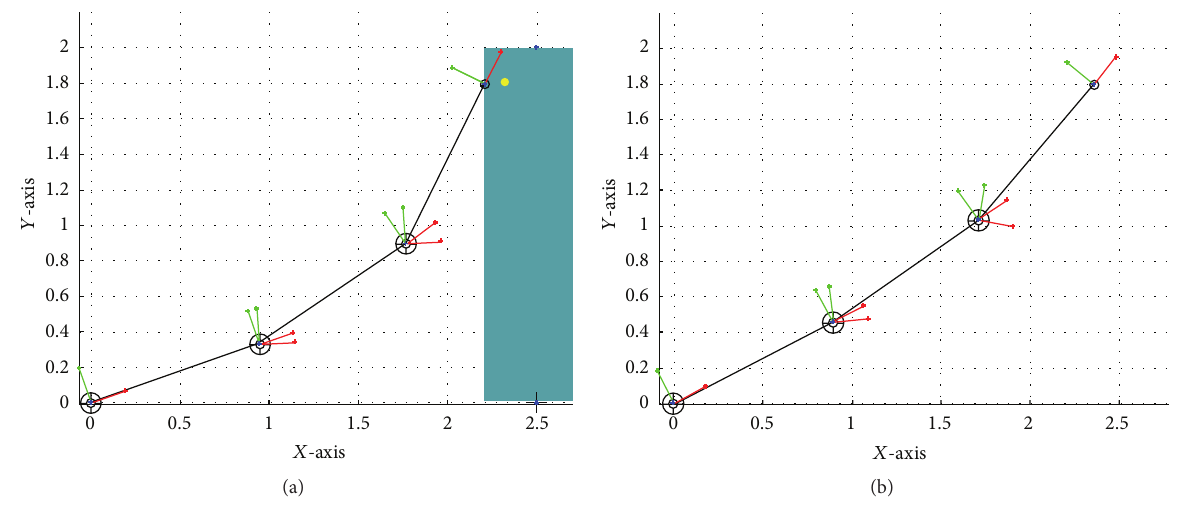
Figure 19: Simulation of the PI System in a planar representation of the DEXTER arm (3DOF) with (a) and without (b) an obstacle: 𝑥 = 1.86 , 𝑦 = 1.5 is the initial position of the End-Effector; 𝑥 = 2.35 , 𝑦 = 1.8 is the final position of the End-Effector; 𝑥 = 2.2 is the position of the